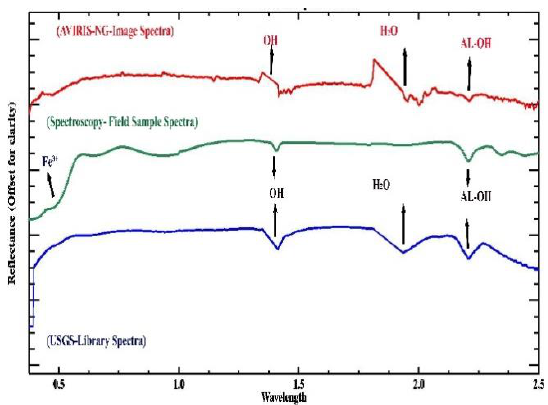
Figure 5: Spectral features of montmorillonite and goethite